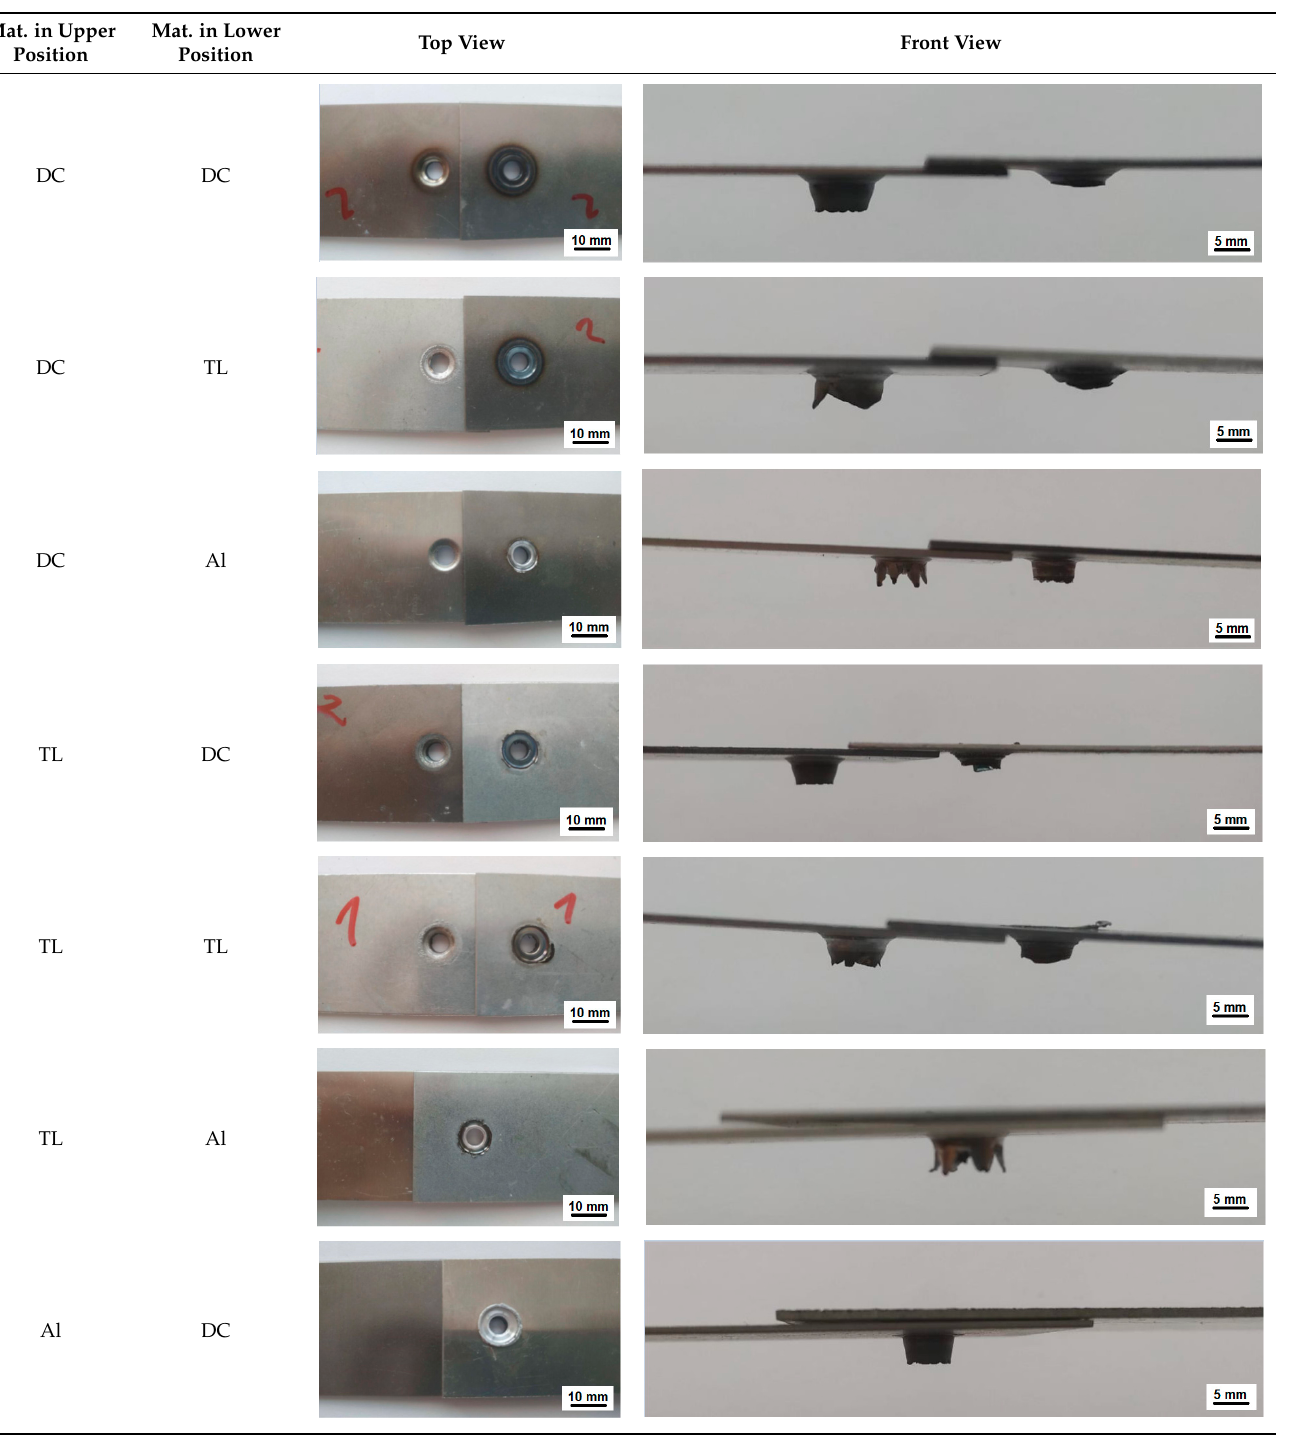
Table 6. Appearance of the created joints (top and front view).